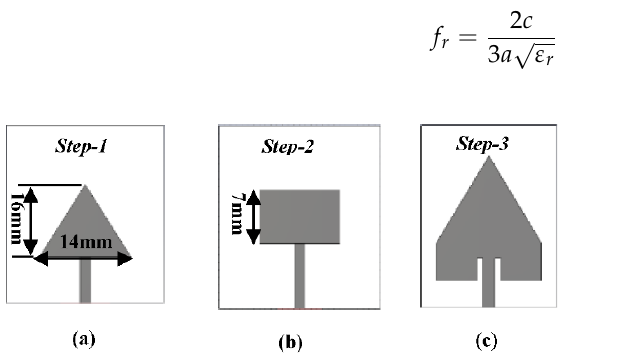
Figure 1. Step -by-Step design of proposed antenna ( a ) Triangular Patch ( b ) Square Patch ( c ) Com- bined Triangular and Square patch.